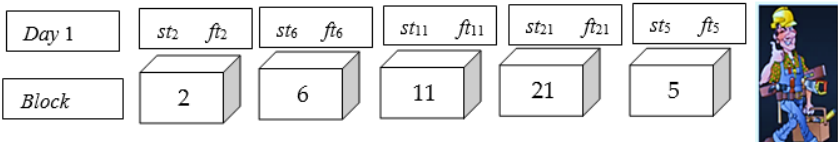
Figure 5. Result of task sequencing for each technician in each day.